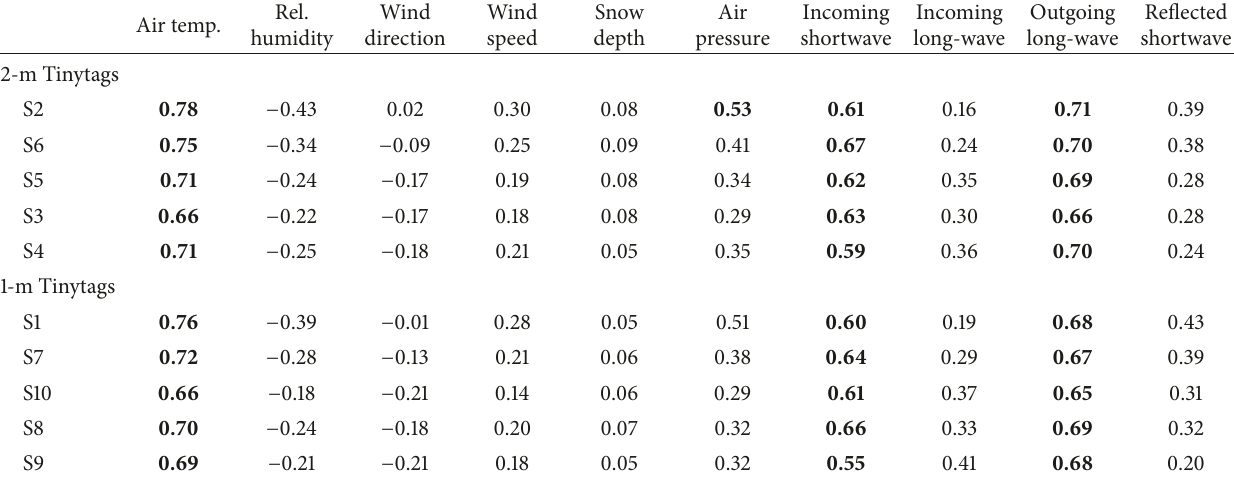
Table 4: Correlation coefficients between surface air temperatures recorded by the Tinytags and meteorological parameters recorded at the DGA automatic weather station, based on hourly data from 21:00 on 21 March to 13:00 on 27 March 2015. Correlations ≥ 0.5 or ≤ − 0.5 are highlighted in